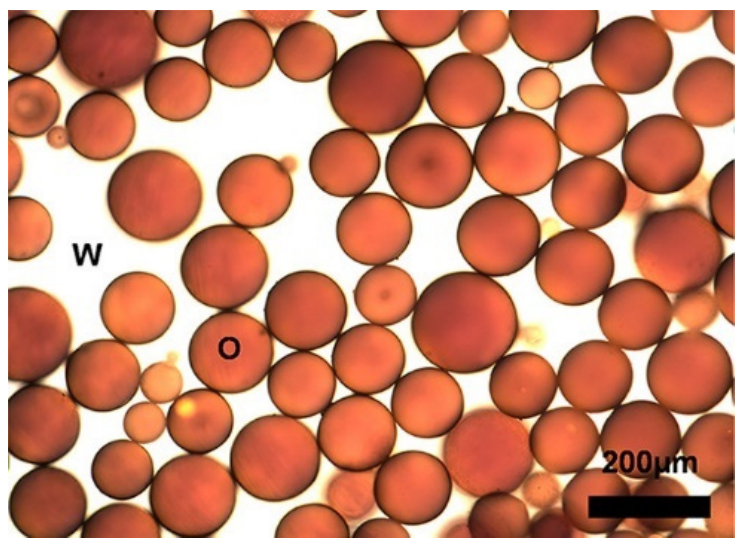
Figure 4. Optical micrographs show oil-in-water emulsions formed with 10 vol% BP-MC 252 crude oil, 0.015 wt % CB (W: water and O: Oil) [46]. (Copyright 2019 American Chemical Society)).